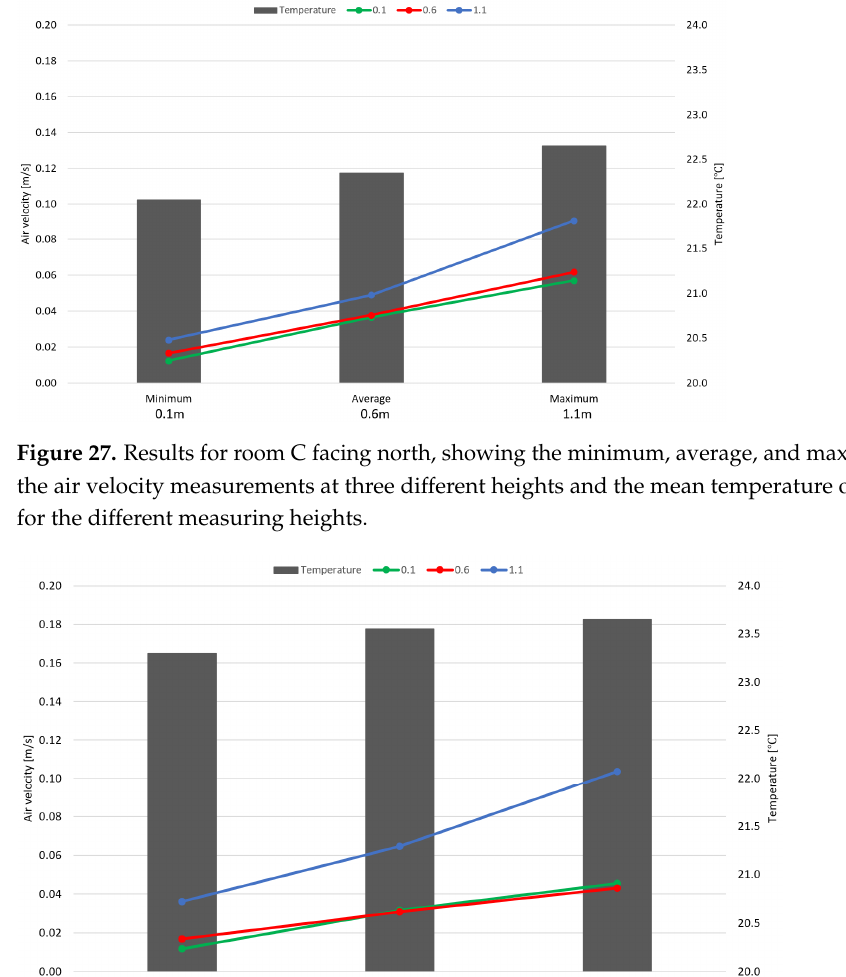
Figure 28. Results for room B facing south, showing the minimum, average, and maximum value for the air velocity measurements at three different heights, and the mean temperature on the right axis for the different measuring heights.